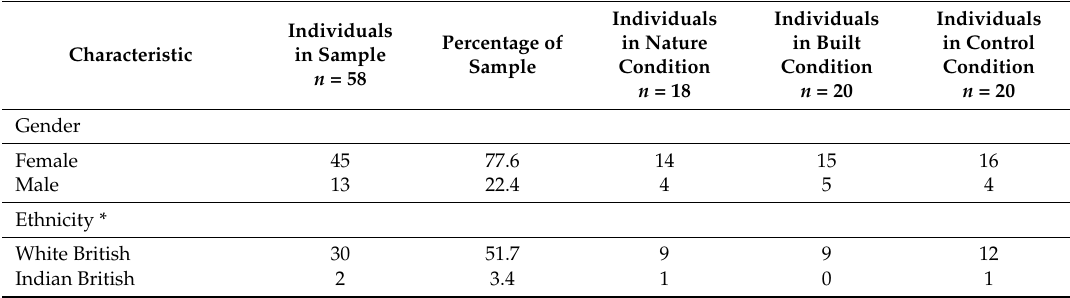
Table 1. Demographic Details for Whole Sample and by